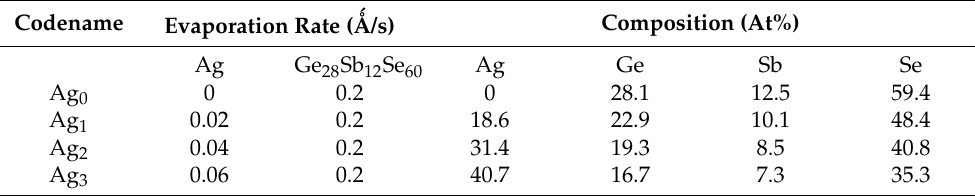
Table 1. The deposition rate and the corresponding composition of the